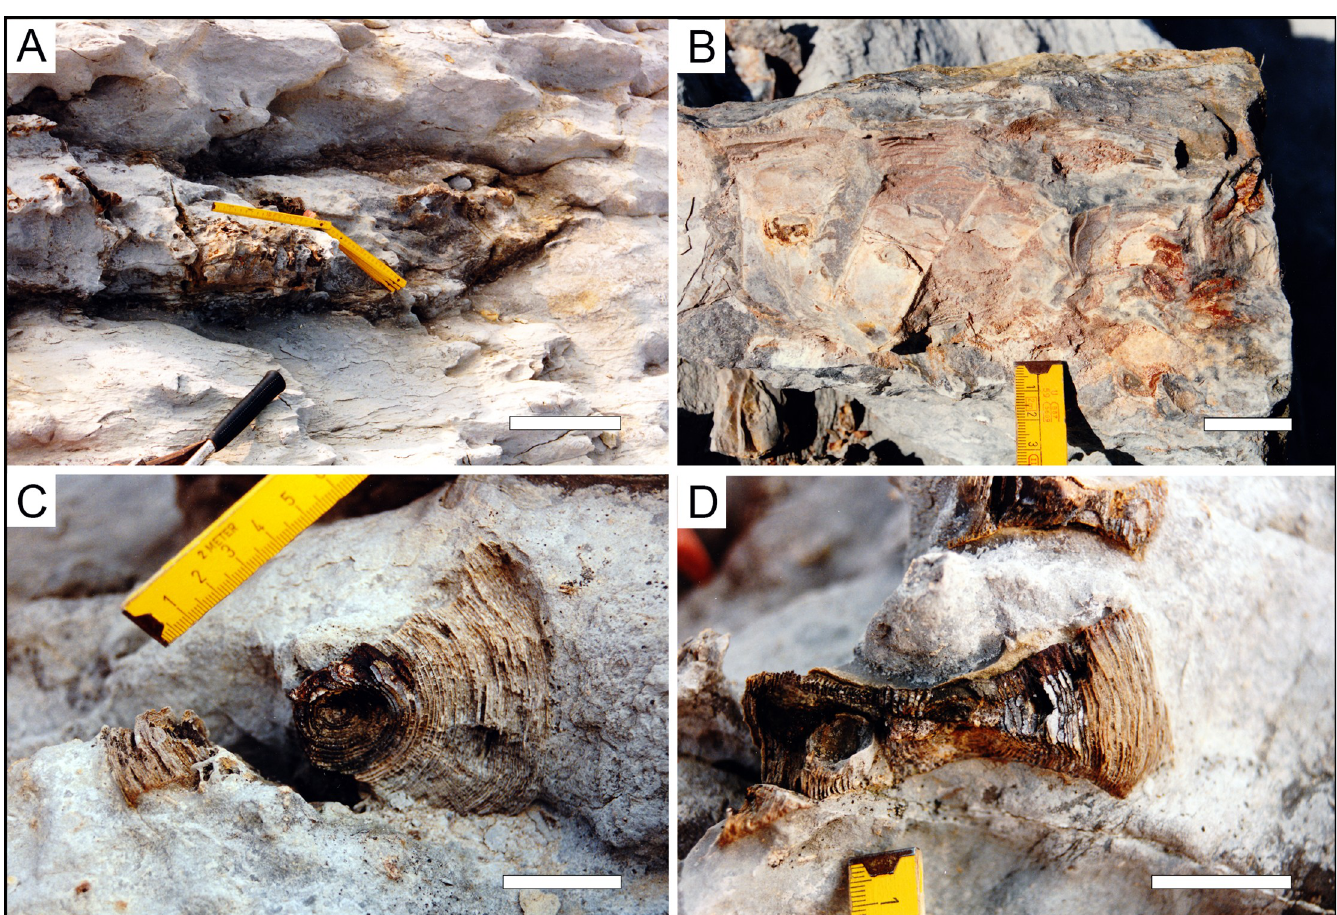
Fig 2. Additional articulated (A, B) and disarticulated shark vertebrae (C,D) found in situ associated with EMRG-Chond-SK-1. Picture courtesy of K. Oppermann, 1997. Scale bars equal 20cm (plate A) and 3cm (plates B, C,